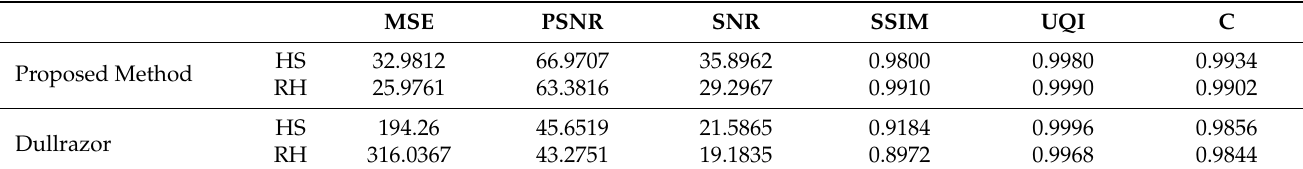
Table 2. Comparison between the proposed algorithm and DullRazor using both RH and HS hair simulators.